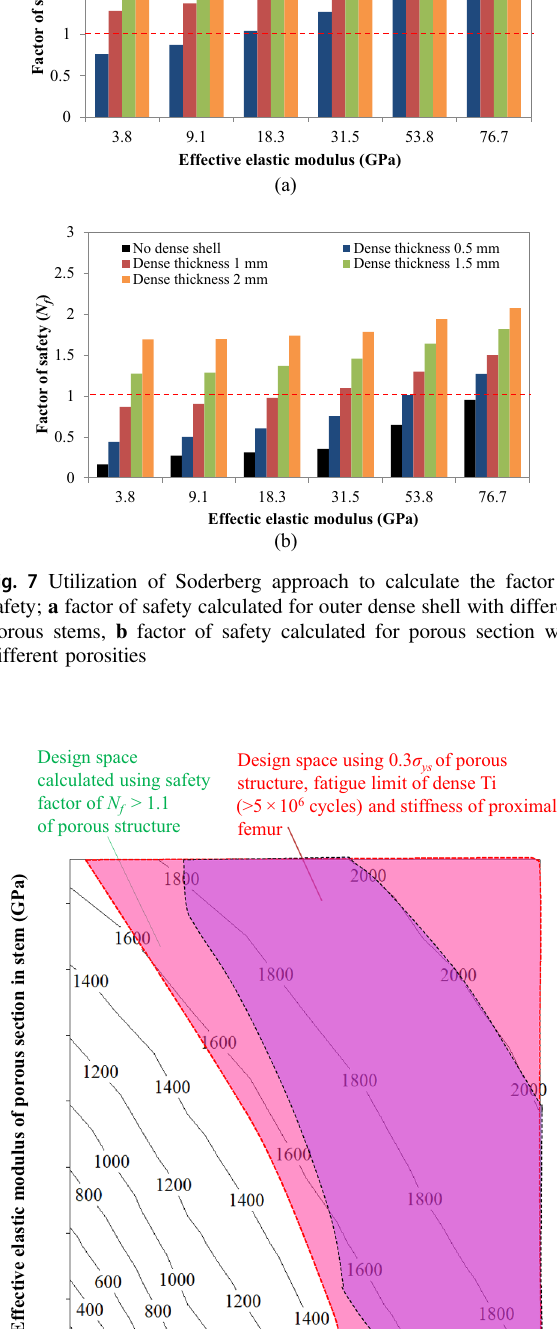
Fig. 8 Design spaces calculated using the Soderberg approach for the safety factor of N f > 1.1 and, stiffness, stresses in porous section and stresses in dense